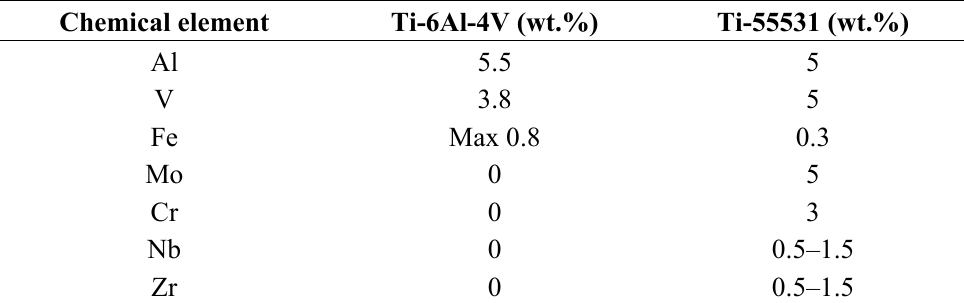
Table 1. Chemical composition of machined